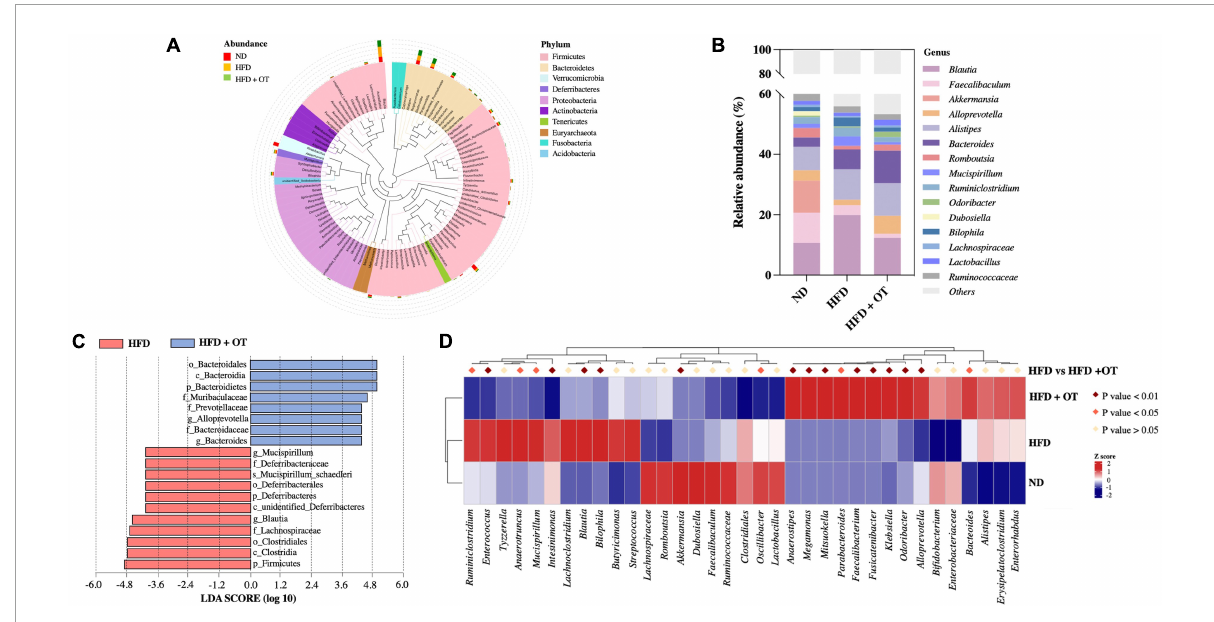
FIGURE6 Oolong tea modulated microbial taxa in HFD-fed mice. (A) Species evolution tree at the phylum level. (B) Relative abundance of gut microbiota at the genus level. (C) Analysis of differences in the microbial taxa shown by LDA score (log10 > 4). (D) Heatmap showing the relative abundance of 35 OTUs in different groups ( n =